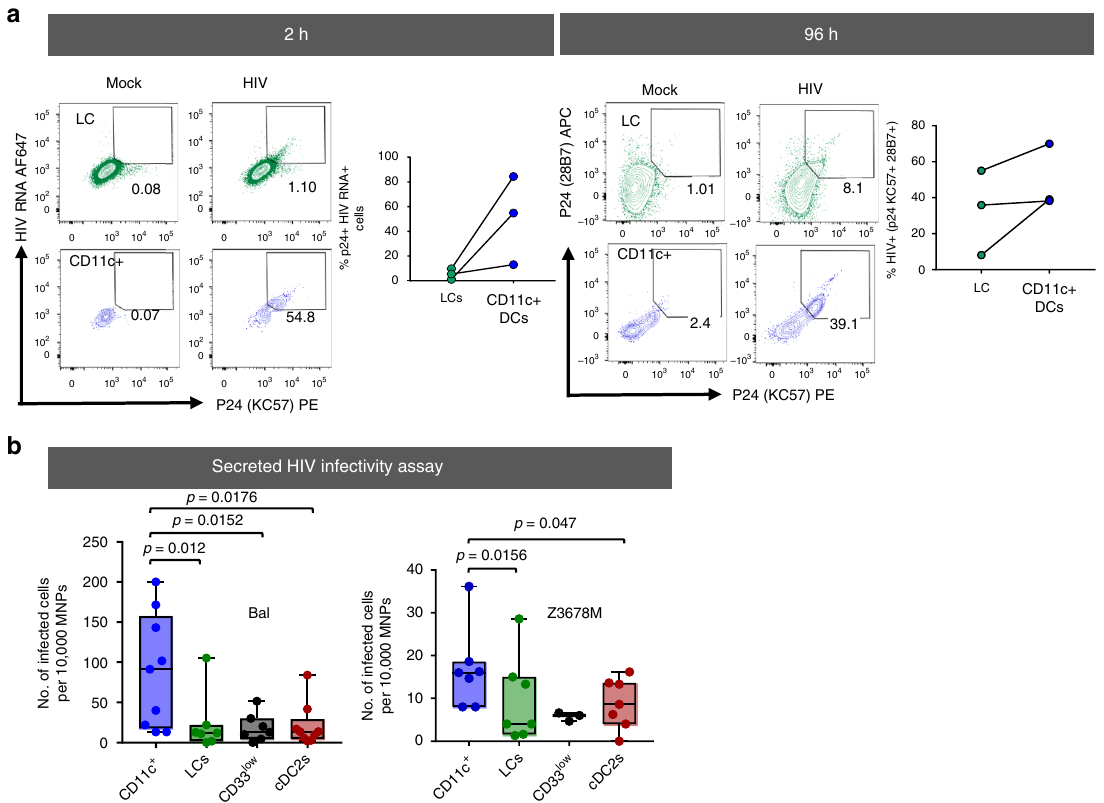
Fig. 7 HIV infectability and transfer capacity of epidermal mononuclear phagocytes. MNPs were liberated from human epidermis using Type IV collagenase. Cells were either infected as a mixed epidermal population or each subset was FACS sorted and then treated with HIV BaL , HIV Z3678M , or mock treated for 2 h, after which the virus was thoroughly washed off and cultured in human skin fi broblast conditioned media. a Mixed epidermal cells were incubated for 2 h with HIV Z3678M , or mock treated then washed 3 times prior to staining with antibodies and HIV p24 and HIV RNA was measured using prime fl ow. LCs and CD11c + DCs were gated on and the %HIV p24 + RNA + cells was analysed. Each dot represents an individual donor with lines indicating the same donor for each subset. Cells were cultured for 96 h and stained for fl ow cytometry with two antibody clones to HIV p24 + (KC57 and 28B7). LCs and CD11c + DCs were gated on and the %HIV p24 + cells was analysed. Each dot represents an individual donor with lines indicating the same donor for each subset. b Cell supernatants we collected and assayed for HIV infectivity using a TZMBL1 infection assay. The number of infected TZMBL1 cells per 10 4 MNPs was calculated and plotted as a box and whisker plots plot. representing, the upper and lower quartile, the central bar represents the median, while the whiskers show the minimum and maximum for each sample, with each dot representing an individual donor. Top panel HIV BaL , (CD11c + = 9, LCs = 7, CD33 low = 7, CDC2 = 9). Statistics comparing the amount of HIV produced by each subset were generated using a Mann – Whitney test. Bottom panel HIV Z3678M , (CD11c + = 67, LCs = 67, CD33 low = 23, CDC2 = 27). Statistics comparing the amount of HIV produced by each subset were generated using a Wilcoxon matched-pairs test, * p =